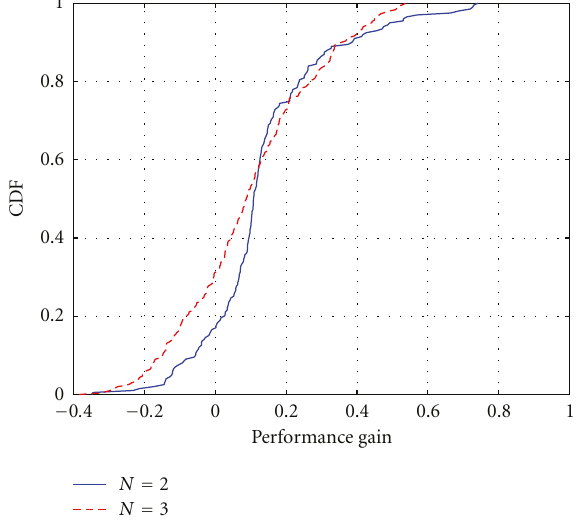
Figure 10: CDF of performance gain over the simple orthogonal channel assignment when system state is fully observable.